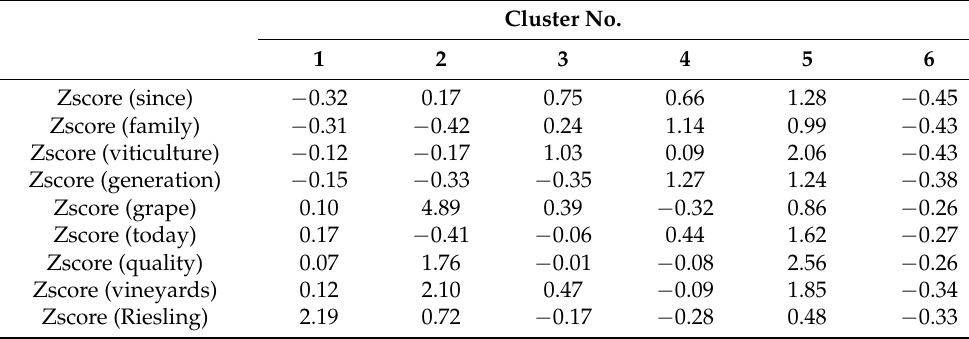
Table 3. Final cluster centers for extracted winery brand identity types.